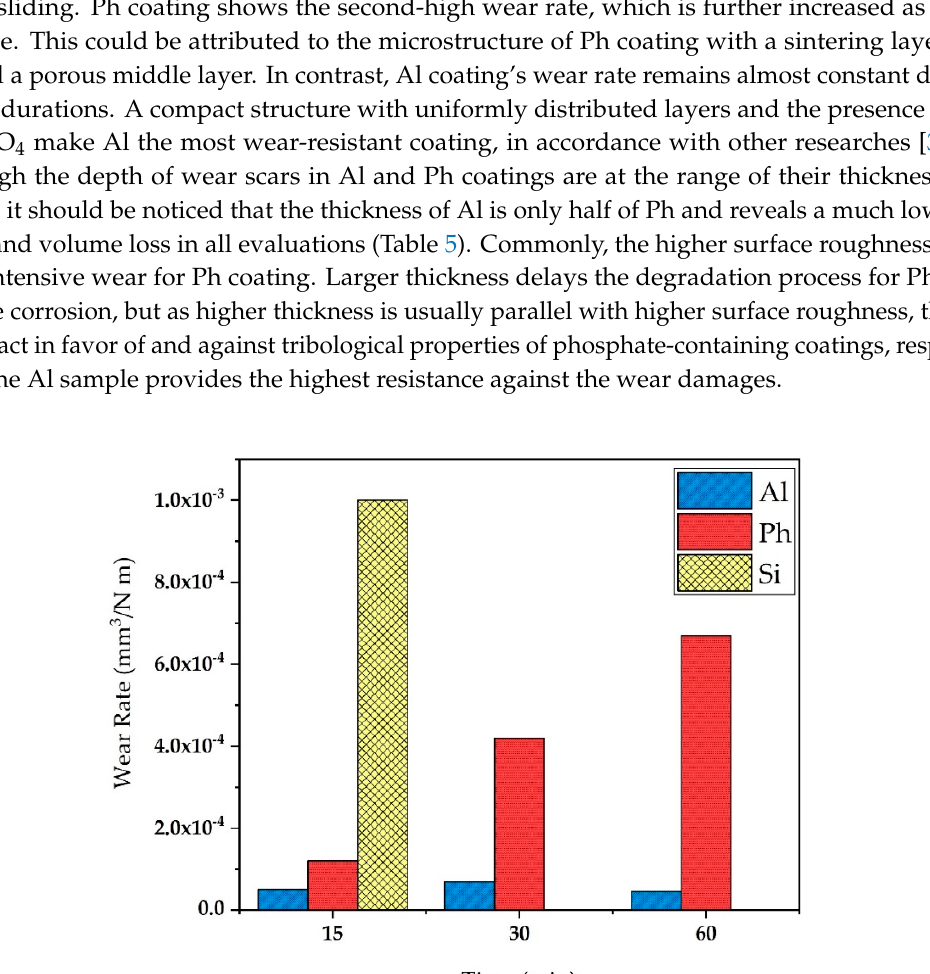
Figure 9. Wear tracks of PEO coatings after dry-sliding tests; ( a ) Al-15 min, ( b ) Ph-15 min, ( c ) Si-15 min, ( d ) Al-30 min, ( e ) Ph-30 min, ( f ) Al-60 min, and ( g ) Ph-60 min.